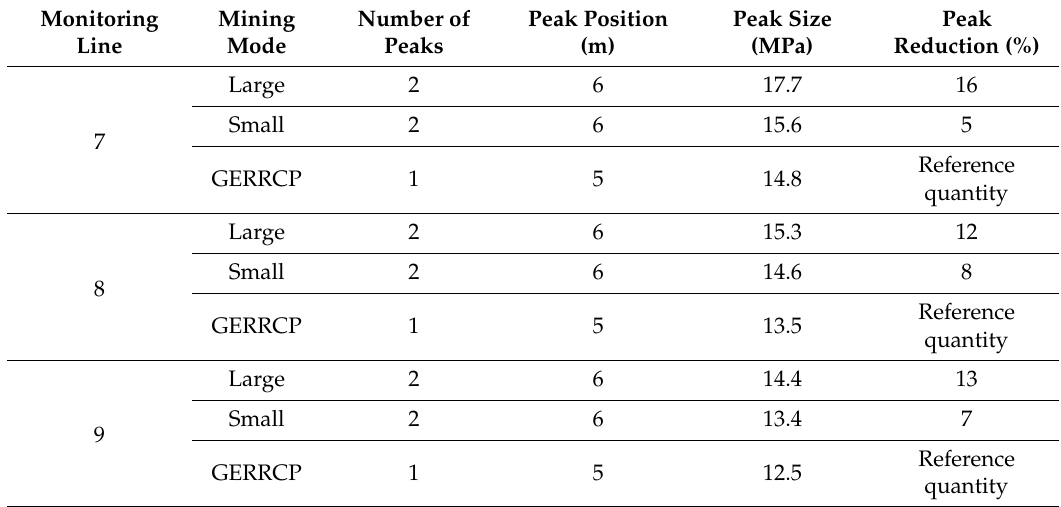
Reference Reference quantity